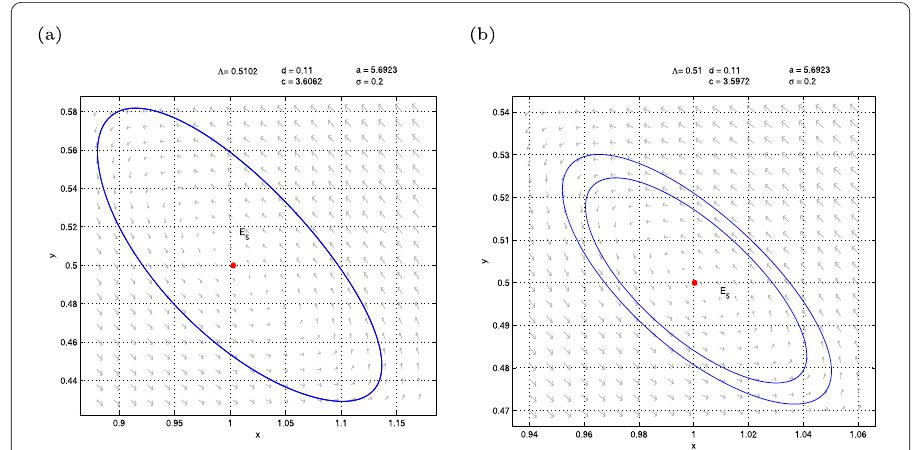
Figure 8 ( a ) One limit cycle enclosing an unstable hyperbolic focus E 5 . ( b ) Two limit cycles enclosing an unstable hyperbolic focus E 5 , and the small one is stable, the large one is